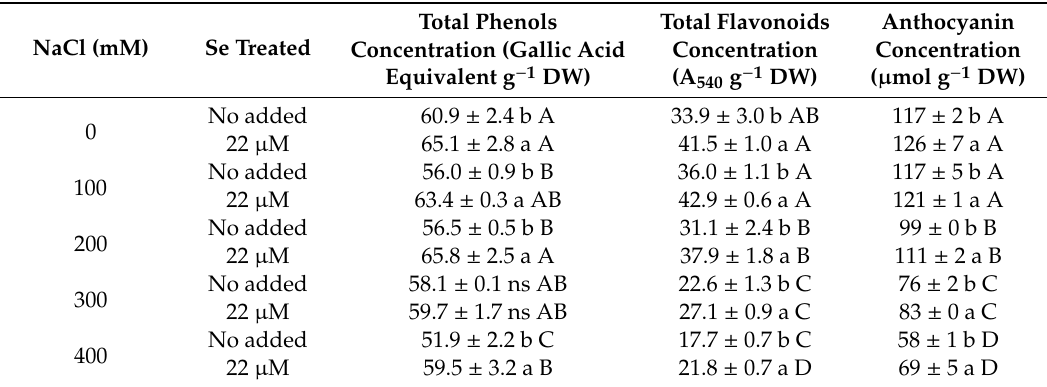
Table 2. Total phenols, total flavonoids, and anthocyanin concentrations of wheat seedlings. NaCl